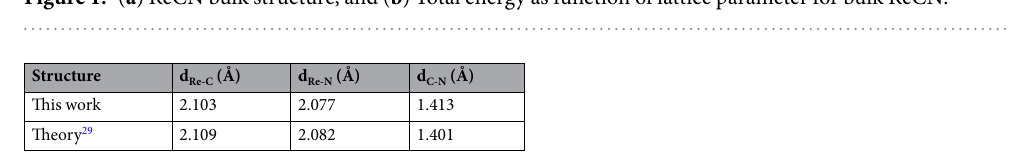
Table 1. Comparison between our calculated distances and previously reported